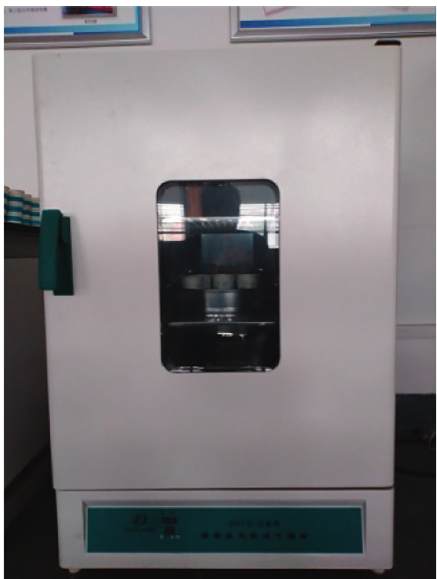
Figure 12: Drying box.